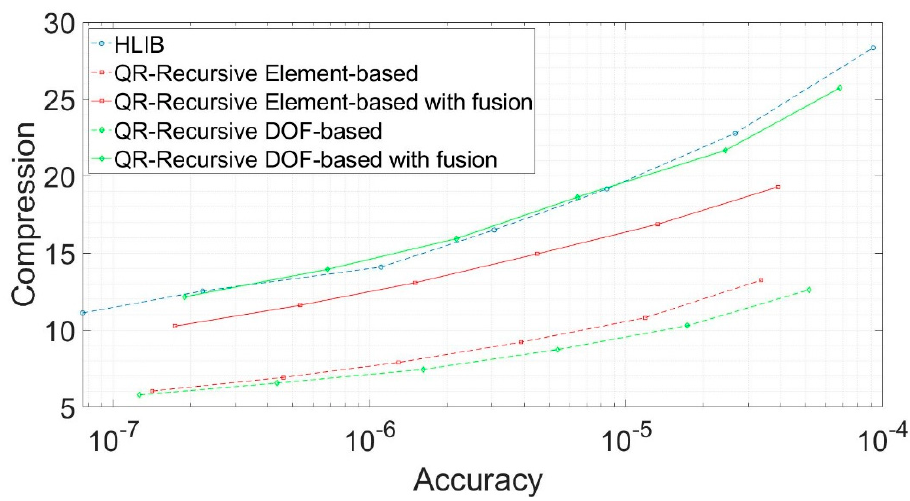
Figure 15. Testcase#1. The Compression versus the Accuracy for various proposed techniques.